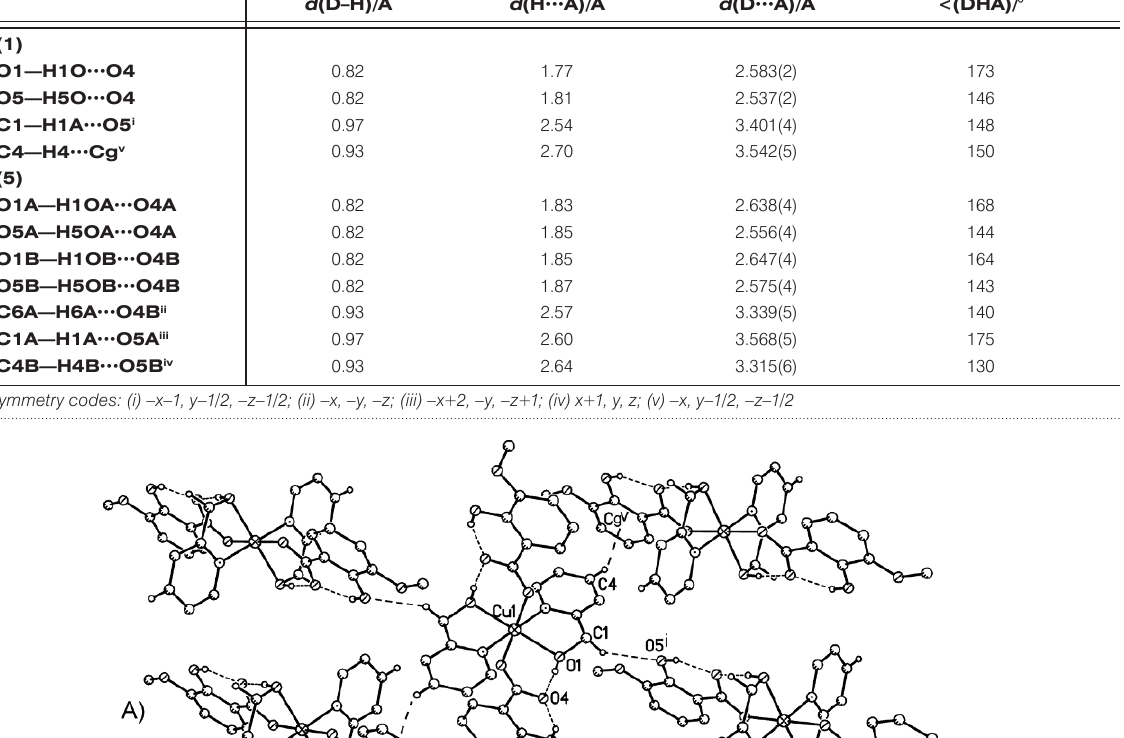
(Fig. 4A). The CH\ π [hydrogen bonds [C4—H4∙∙∙Cg v (Symmetry code: (v) –x, y–1/2, –z–1/2) with C4∙∙∙Cg distance of 3.542(5) Å] [63] is also observed in crystal packing of 1 (Fig. 4 A). And finally, 3-methoxysalicylate